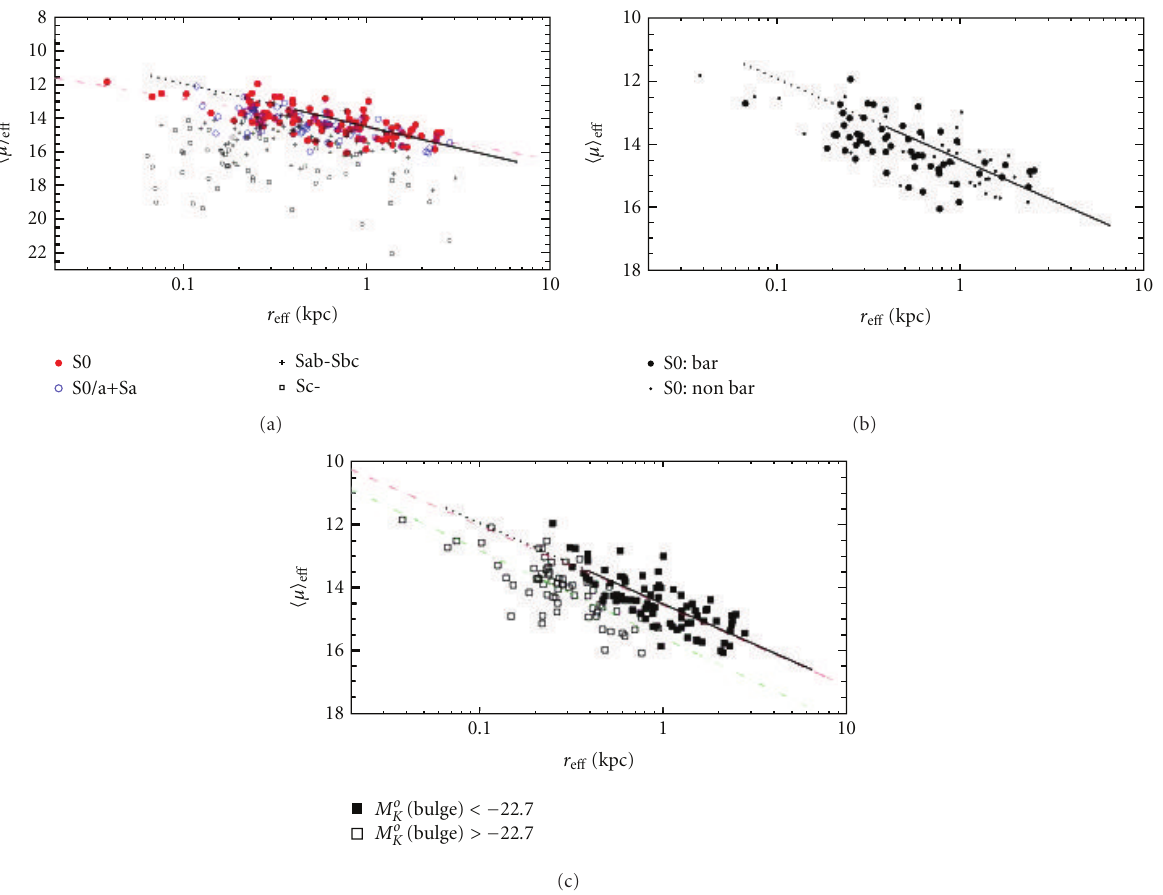
Figure 8: The Kormendy relation for bulges of S0, early-type and late-type spirals. In all panels the full line represents the KR of elliptical galaxies in the Coma cluster. The dotted black line corresponds to the extension of the KR of ellipticals towards galaxies with smaller e ff ective radius. The red dashed line of the upper panel represents the KR for the S0 bulges. The red and green dashed lines in the lower panel show the KR for S0 bulges brighter and fainter than M k = − 22 . 7, respectively. Credit: Laurikainen et al. [21]. Reproduced by permision from